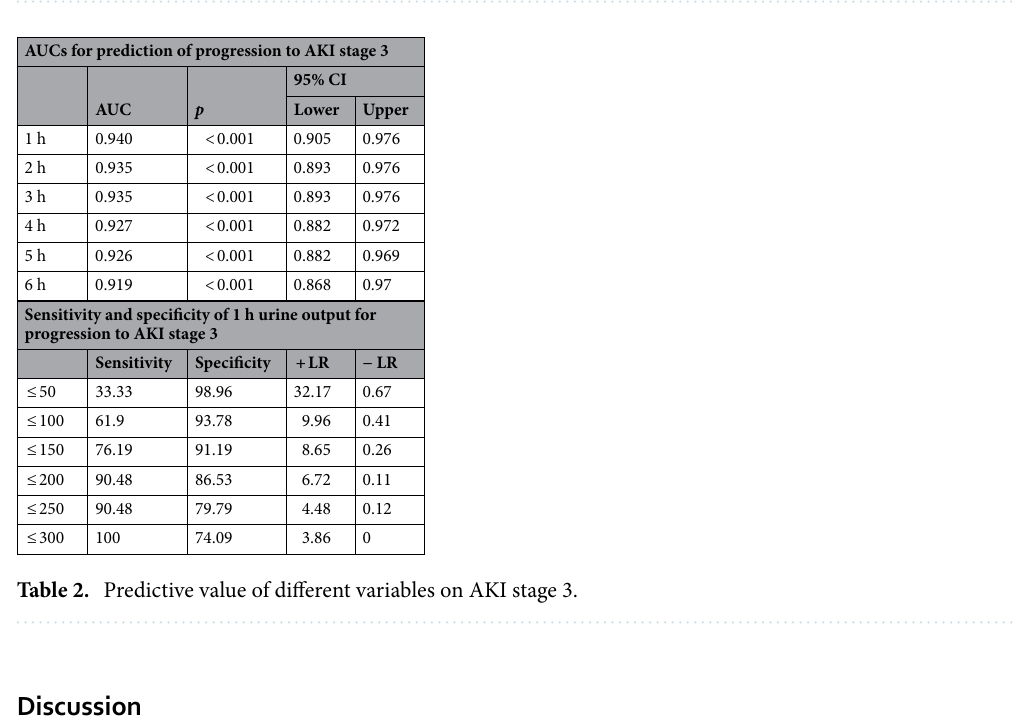
Figure 2. ( A ) Urine output during the first 6 h after the FST. The urine output per hour was recorded accurately; ( B ) Creatinine before and within 7 days after liver transplantation ( POD post-operation day; ( C ) Survival curves of recipients at different AKI stages. The survival outcome after the first six mouths was significantly in AKI stage 3 than in the other group ( p < 0.05).